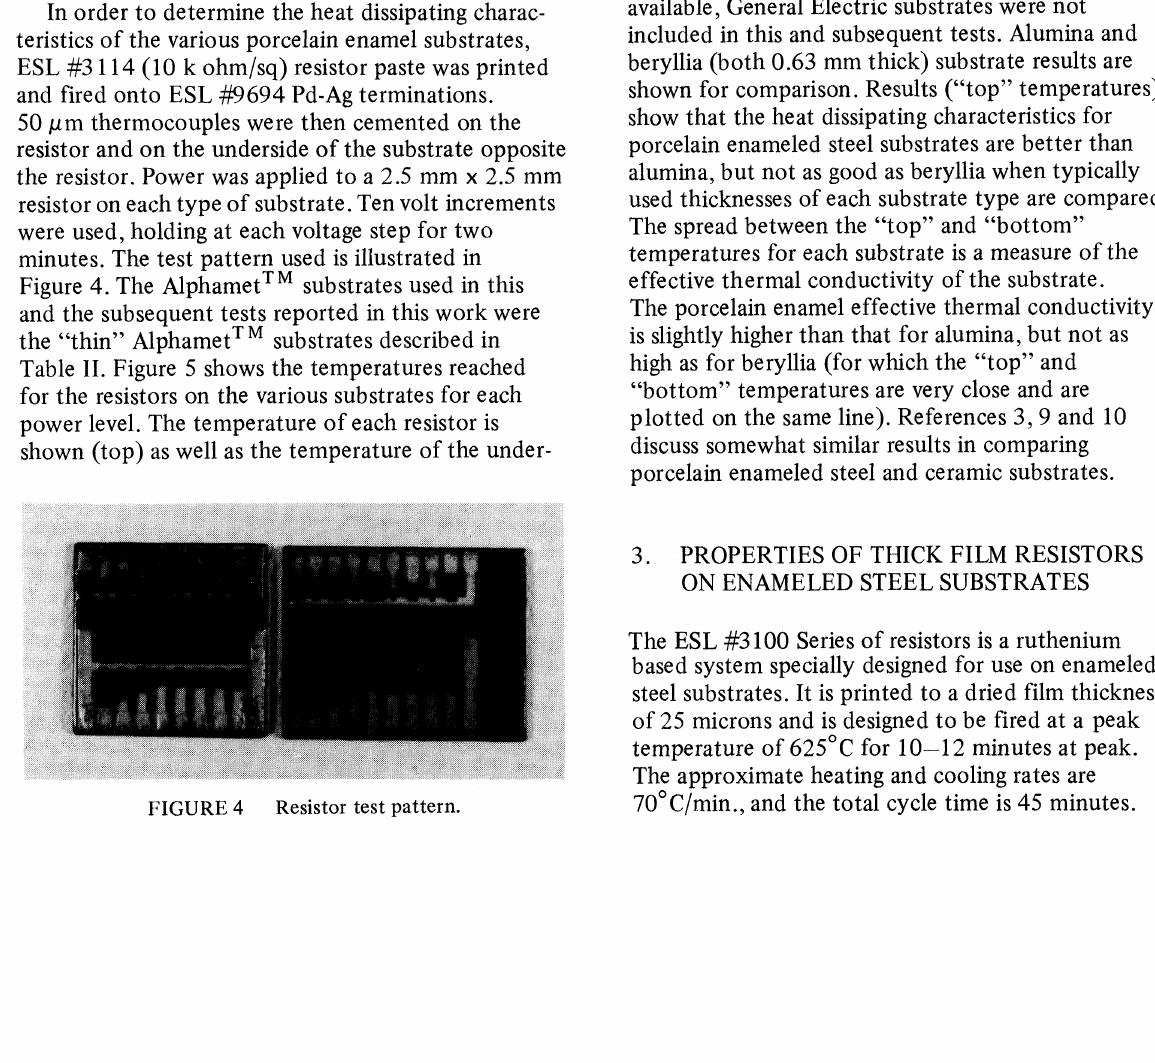
Effect of substrate type on the temperature attained under load.